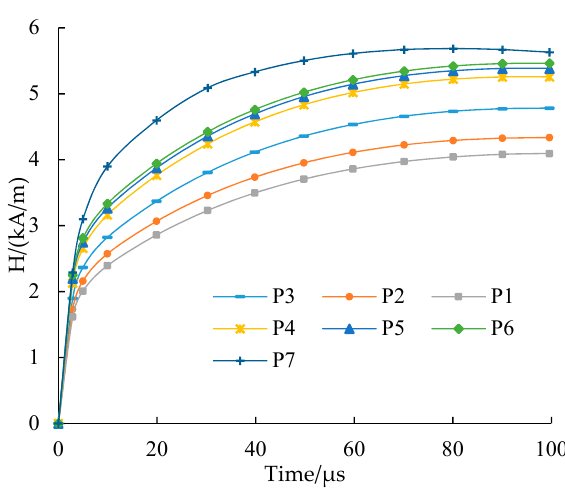
Figure 4. Magnetic field intensity time-domain variation diagrams of probes at different positions in the nacelle.